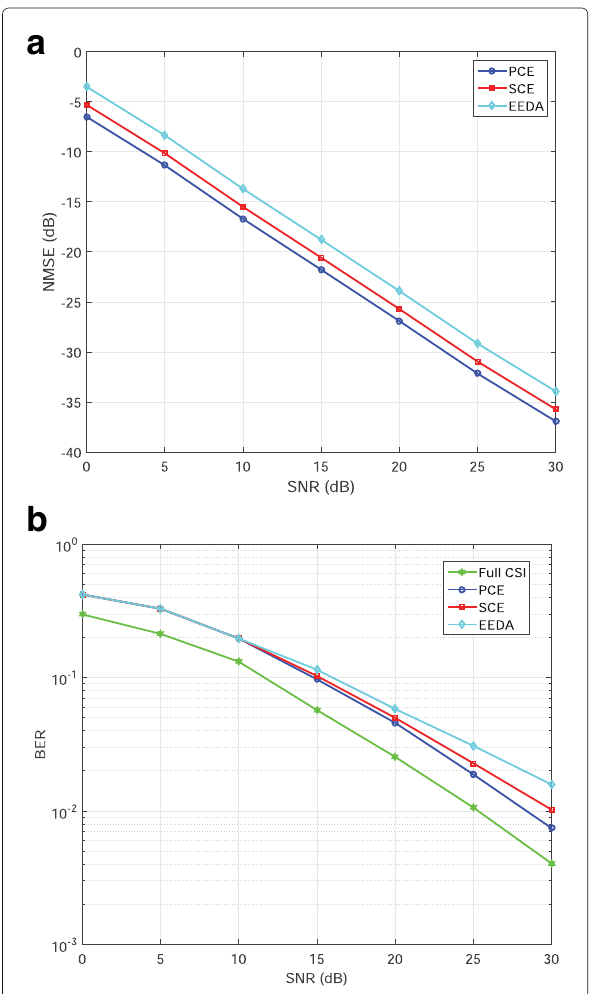
Fig.4 Performance comparisonfor different pilot allocation algorithms. a NMSE performance metric and b BER performance metric